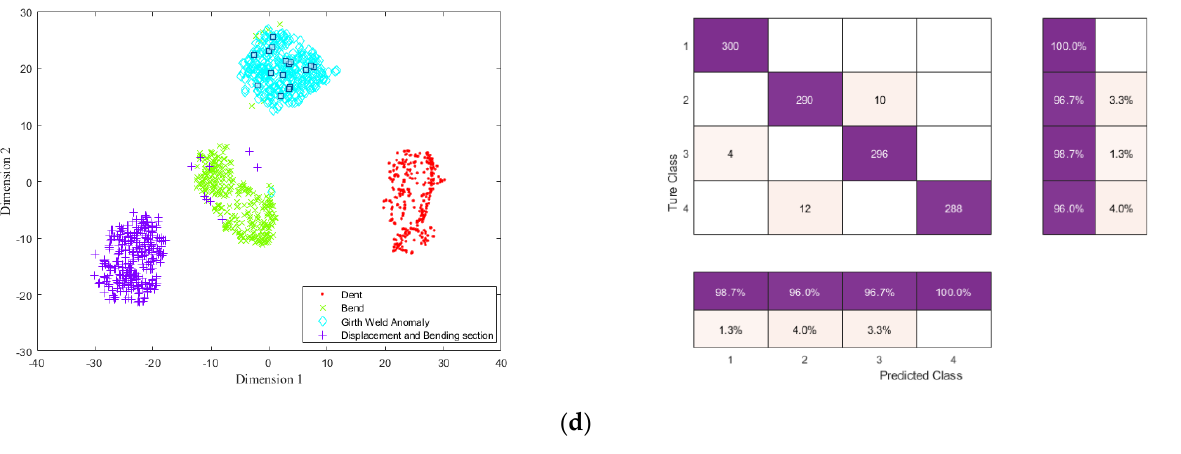
Figure 11. Visualization results and confusion matrix of different methods. ( a ) Depiction of the BP neural network. ( b ) Depiction of the SVM. ( c ) Depiction of the DBN. ( d ) Depiction of the improved DBN.